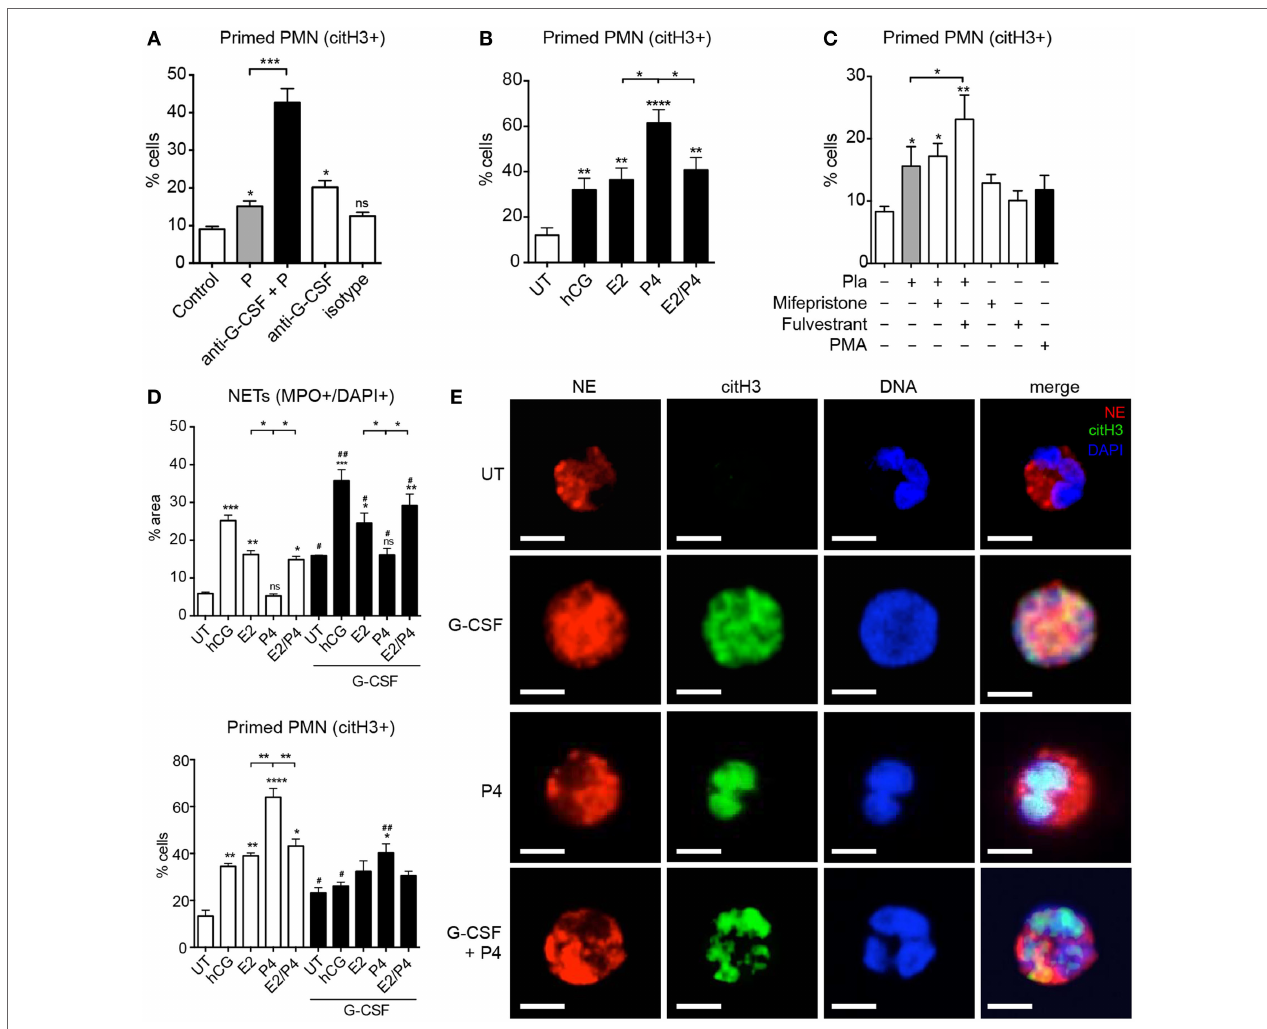
FigUre 4 | sex hormones differentially modulate g-csF-driven neutrophil pro-neTotic priming . (a) Morphometric analysis of the pro-NETotic primed (citH3 + ) neutrophils from healthy non-pregnant donors after in vitro incubation of control neutrophils with pooled pregnancy plasma with and without in vitro pretreatment with anti-G-CSF neutralizing antibody compared to the priming activity of control plasma. (B) Morphometric analysis of the pro-NETotic primed (citH3 + ) neutrophils from healthy non-pregnant donors after in vitro incubation of control neutrophils with physiologic pregnancy concentrations of hCG (50 IU/ml), E2 (20 ng/ml), P4 (50 ng/ml), and the combination of E2 and P4 for 3 h. (c) Morphometric analysis of the pro-NETotic primed citH3 + neutrophils from healthy non-pregnant donors under in vitro hormonal treatment and after in vitro preincubation of control neutrophils with the sex hormone inhibitors mifepristone and fulvestrant. (D) Morphometric analysis of the NETotic (MPO + /DAPI + ) and pro-NETotic primed (citH3 + ) neutrophils from healthy non-pregnant donors without and with pretreatment with 12.5 ng/ml rhG-CSF for 1 h (lower panel) and stimulation with the gestational hormones hCG, E2, P4, and the combination of E2 and P4 for additional 2 h in vitro . (e) Fluorescent immunostaining and confocal microscopy for NE (red), citH3 (green), and DNA (blue) after a 3 h in vitro coculture of control neutrophils with rhG-CSF and addition of P4 compared to untreated control neutrophils. Scale bars: 10 μ m. Data are presented as mean ± SEM. * P < 0.05, ** P < 0.01, *** P < 0.001, and **** P < 0.0001 (one or two way ANOVA followed by Bonferroni’s multiple comparison post-test). All experiments were performed at least three times with consistent